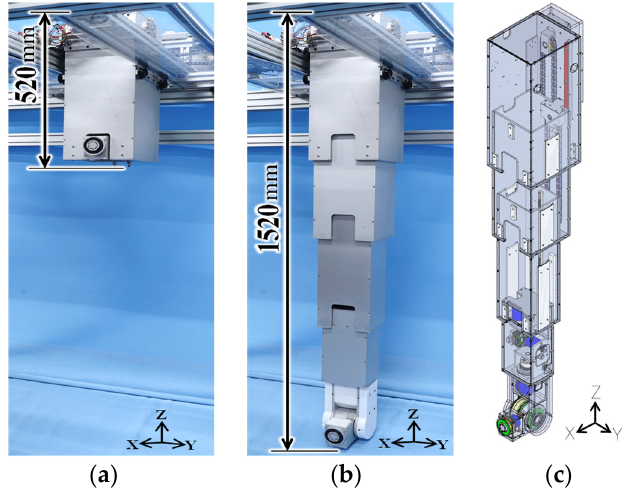
Figure 5. ( a ) Contraction, ( b ) Extension, ( c ) CAD. Telescopic arm.